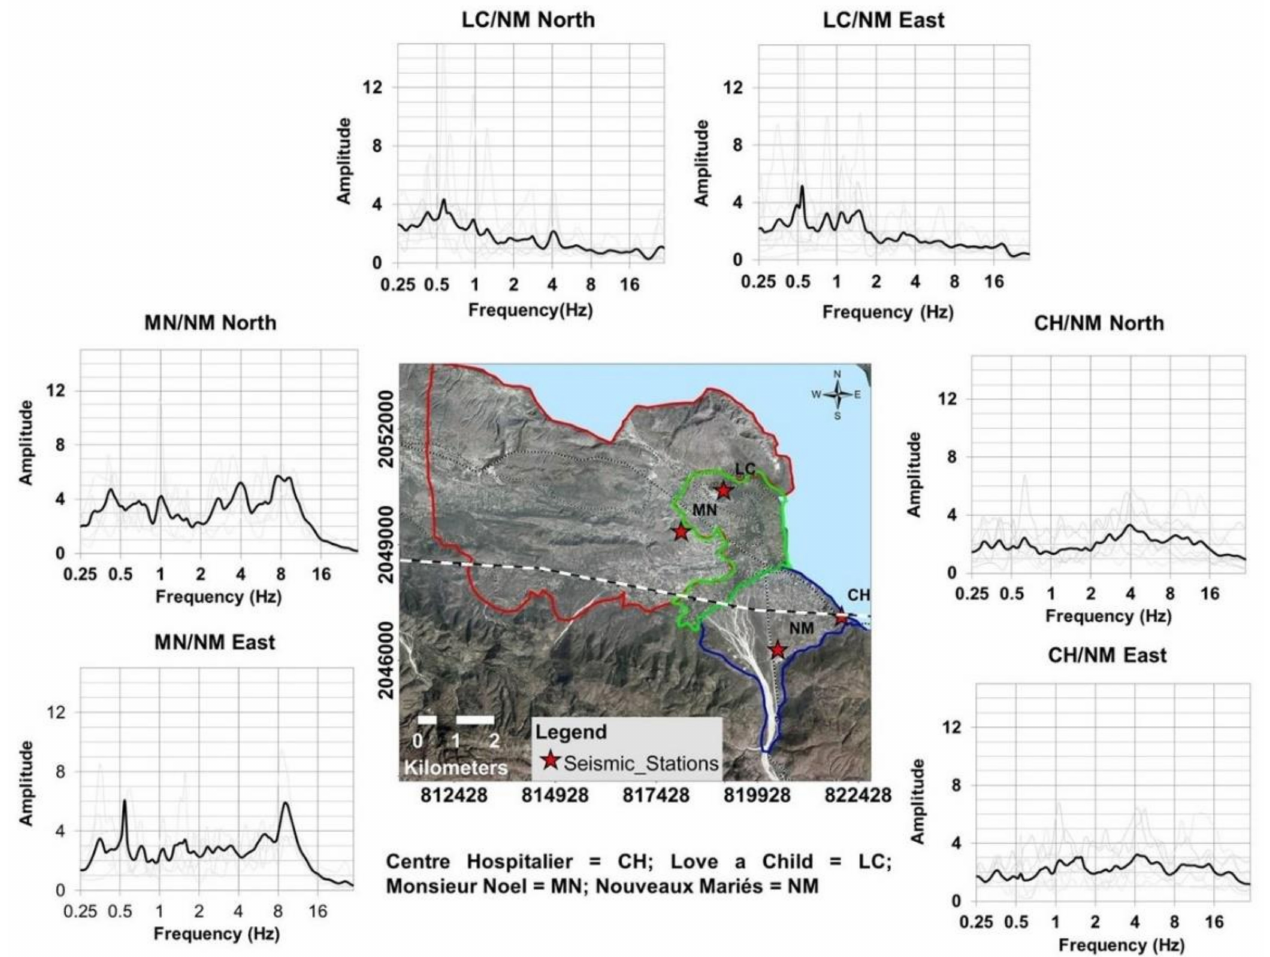
Figure 12. Distinct EW (East) and NS (North) SSR for the stations CH, MN and LC, using NM as reference. The black line marks the EPGF